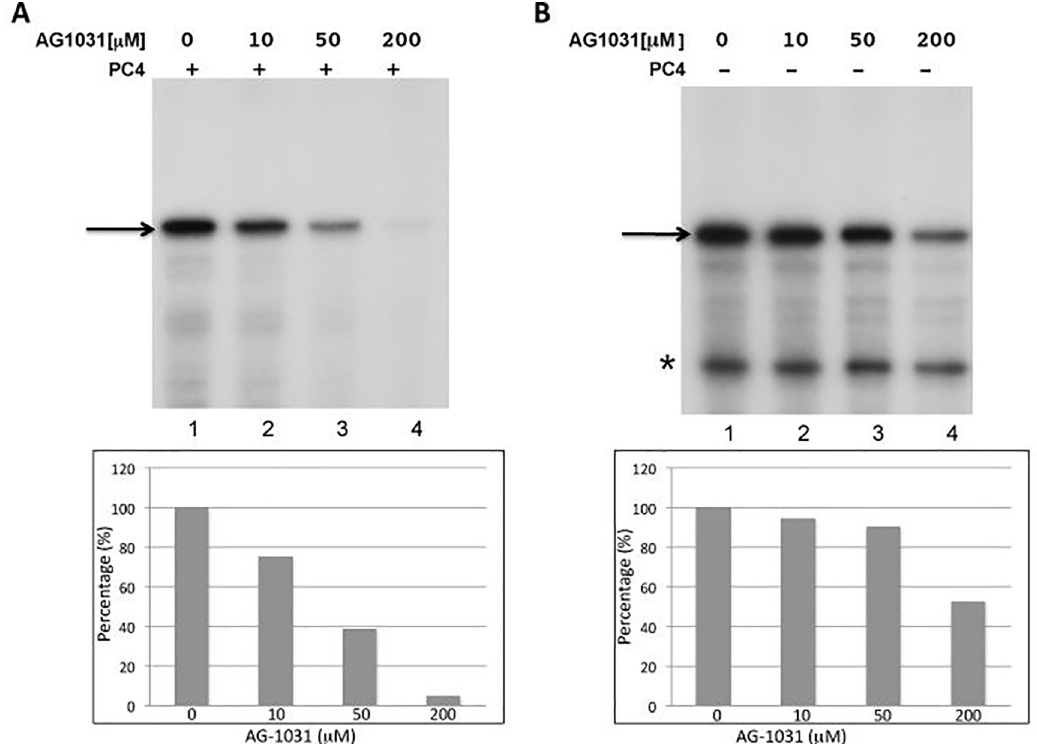
Fig 2. In vitro transcriptions contained affinity purified RNA polymerase II, TFIID, and TFIIH and recombinant TFIIA, TFIIB, TFIIE, TFIIF, and the HNF-4 activator in the presence (A) or absence (B) of recombinant PC4. Drug additions were as indicated. Arrows identify the full-length G- free product originating at the authentic transcription start site. The asterisk in panel B identifies a non- specific RNA that is observed in the absence of PC4. Specific products were quantified and percent inhibition was plotted as a function of AG-1031 concentration (lower